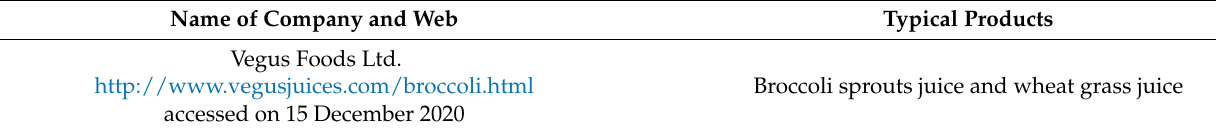
Table A15. High pressure treated products by the company Vegus Foods